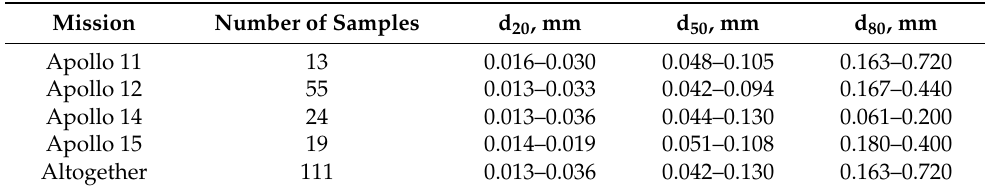
Table 1. Lunar soil grain distribution based on the results obtained after missions Apollo 11, 12, 14, and 15